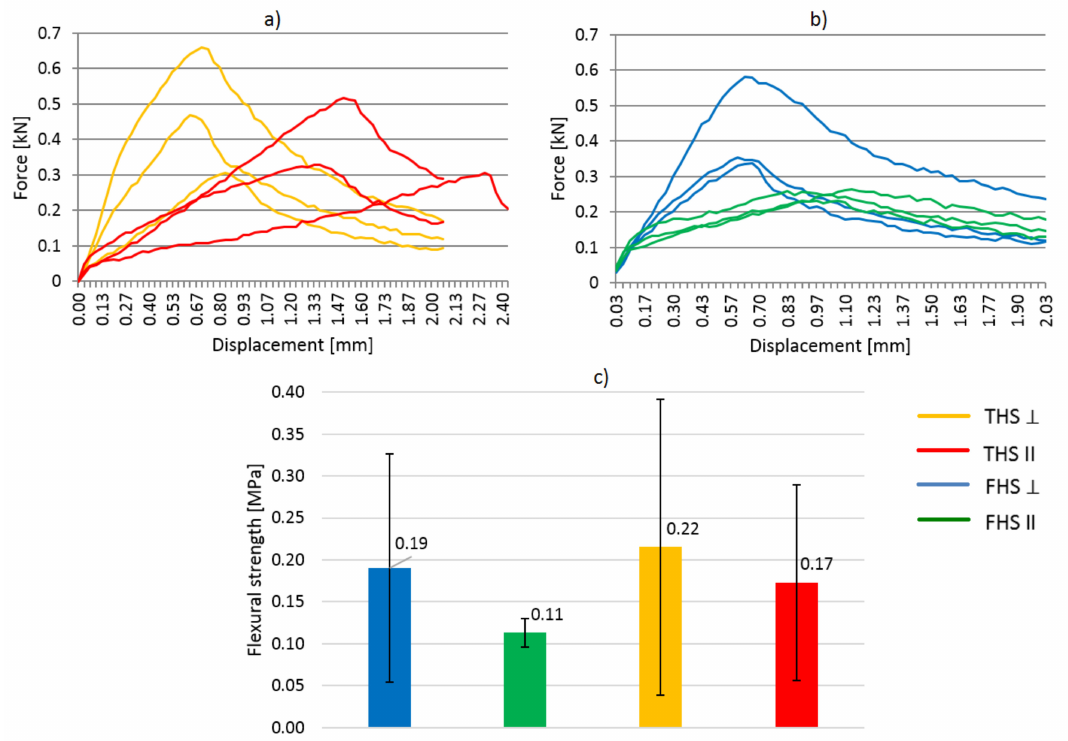
Figure 9. Results of flexural strength test, ( a ) THS composites, ( b ) FHS composites, ( c ) values of flexural strength (THS and FHS